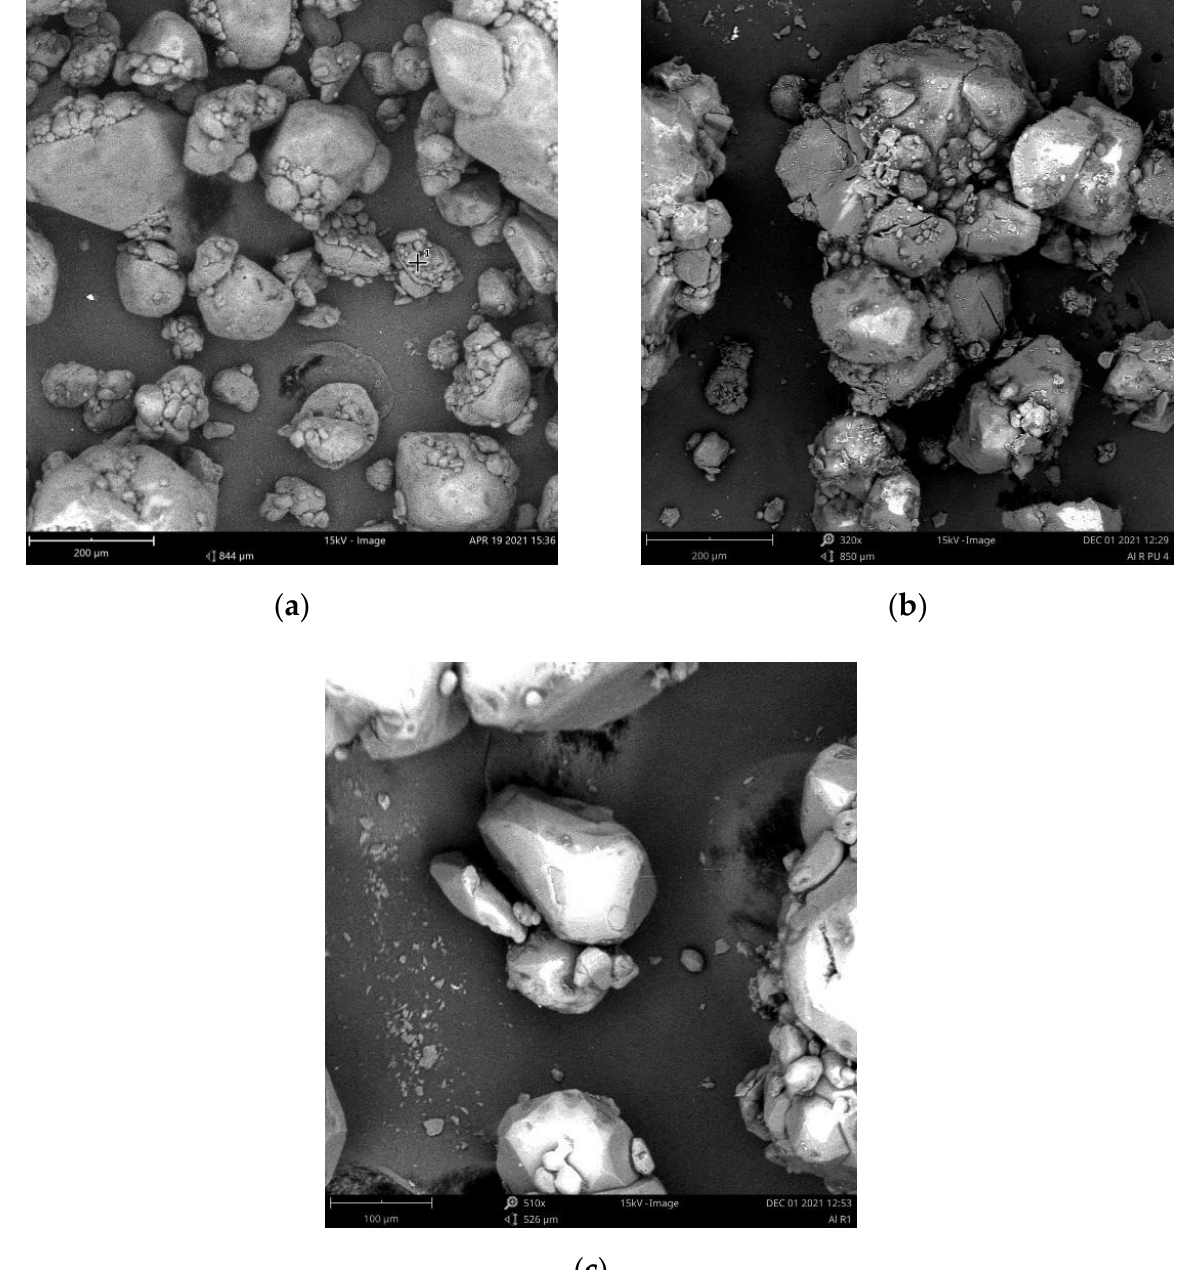
Figure 2. SEM analysis of hexogen ( a ) and coated hexogen ( b , c ).